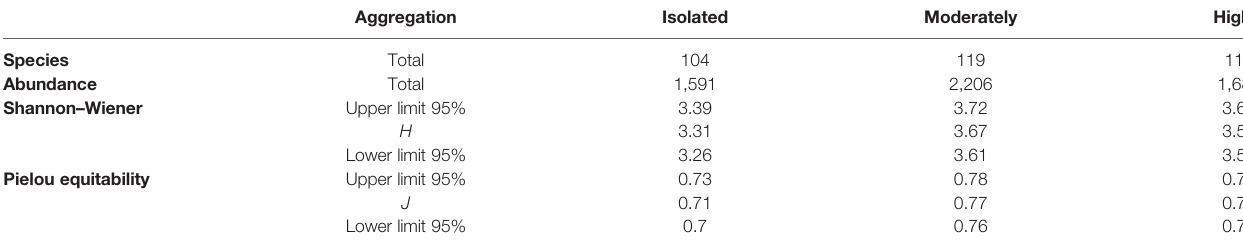
TABLE 6 | Summary of faunal species and abundance, diversity index ( H ), and equitability ( J ) by each level of aggregation of rhodoliths. Aggregation